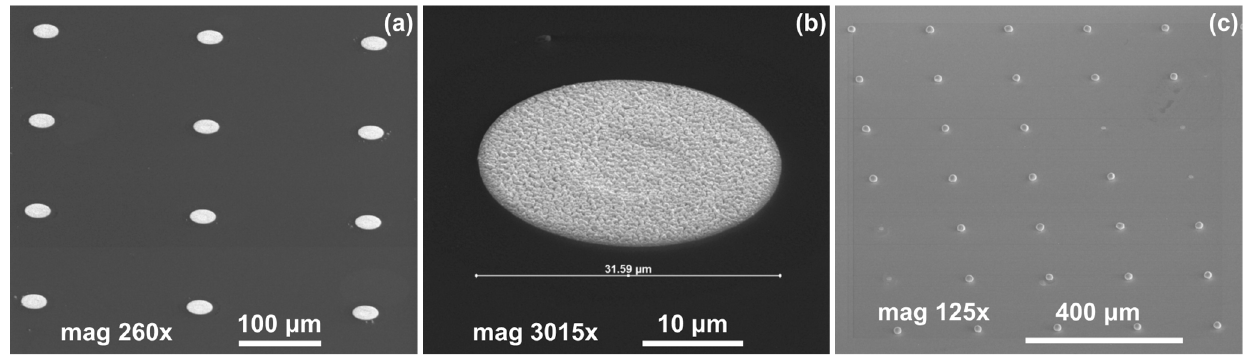
Figure 4. ( a ) SEM images of empty spots after indium bumps; ( b ) an empty spot after indium bump; ( c ) an array of indium bumps with some missing.